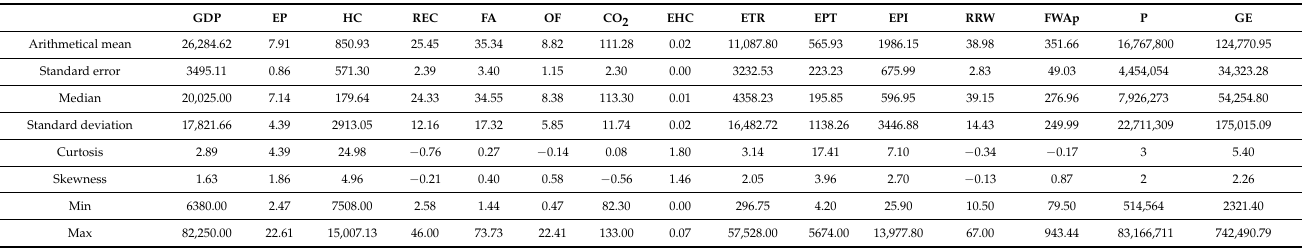
Table A1. Data for